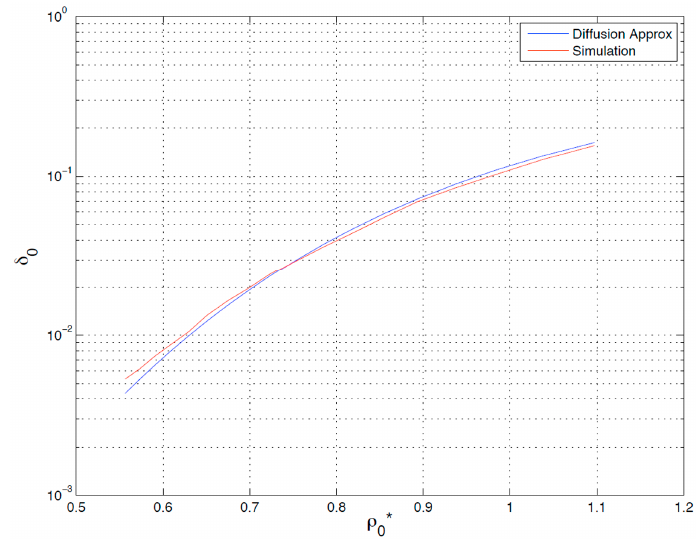
Figure 7. Analytical versus simulation results: probability of overflow for Buffer-0 versus its load (2 Buffers, and m = 2).